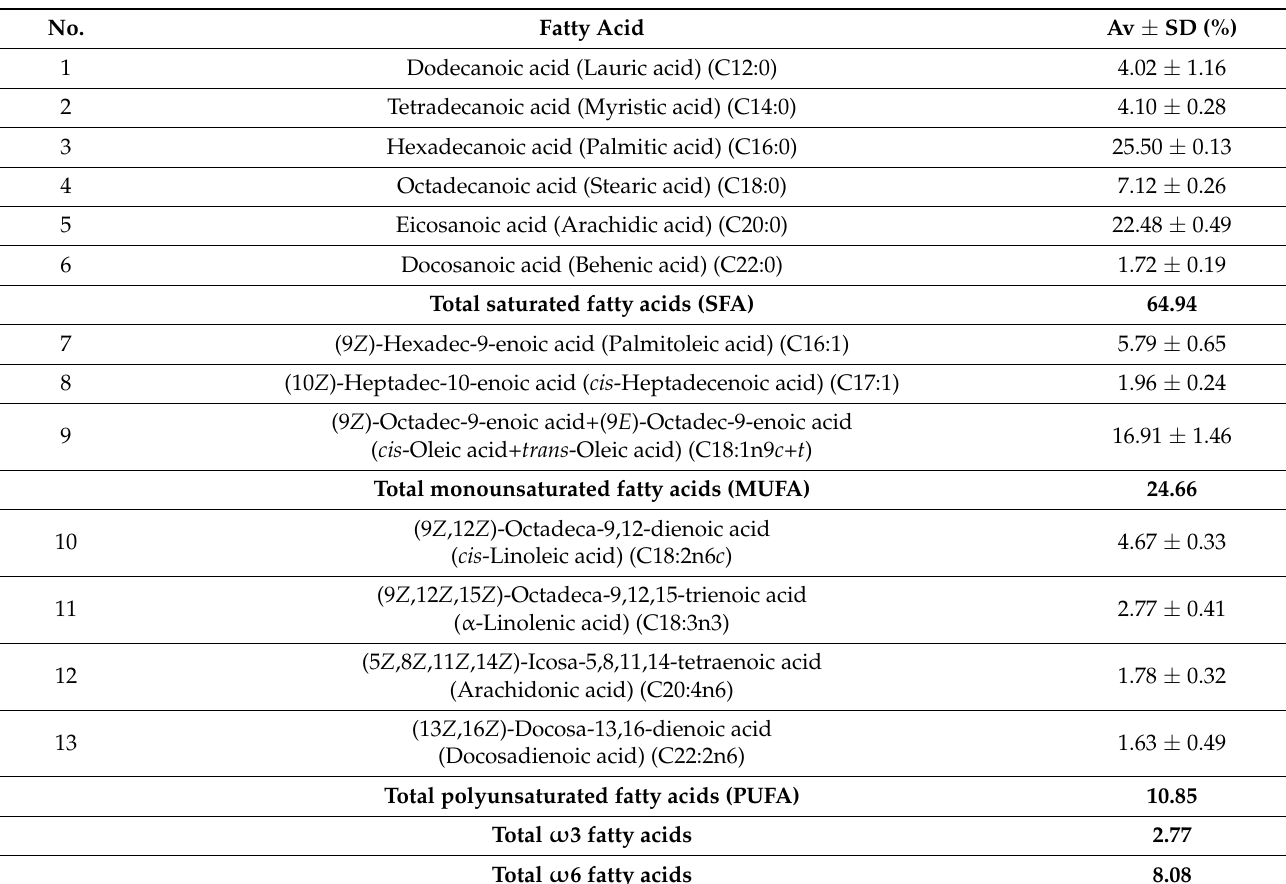
Table 3. Fatty acid composition of C. adhaerens determined by GC-FID.